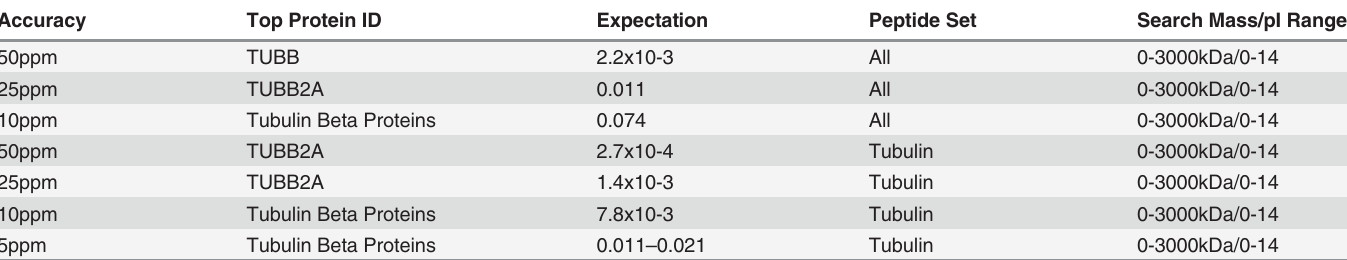
Table 2. Identification of tubulin peptides by ProFound peptide mass fingerprinting using immunoprecipitation experiments and averaged MAL- DI-TOF/TOF data.